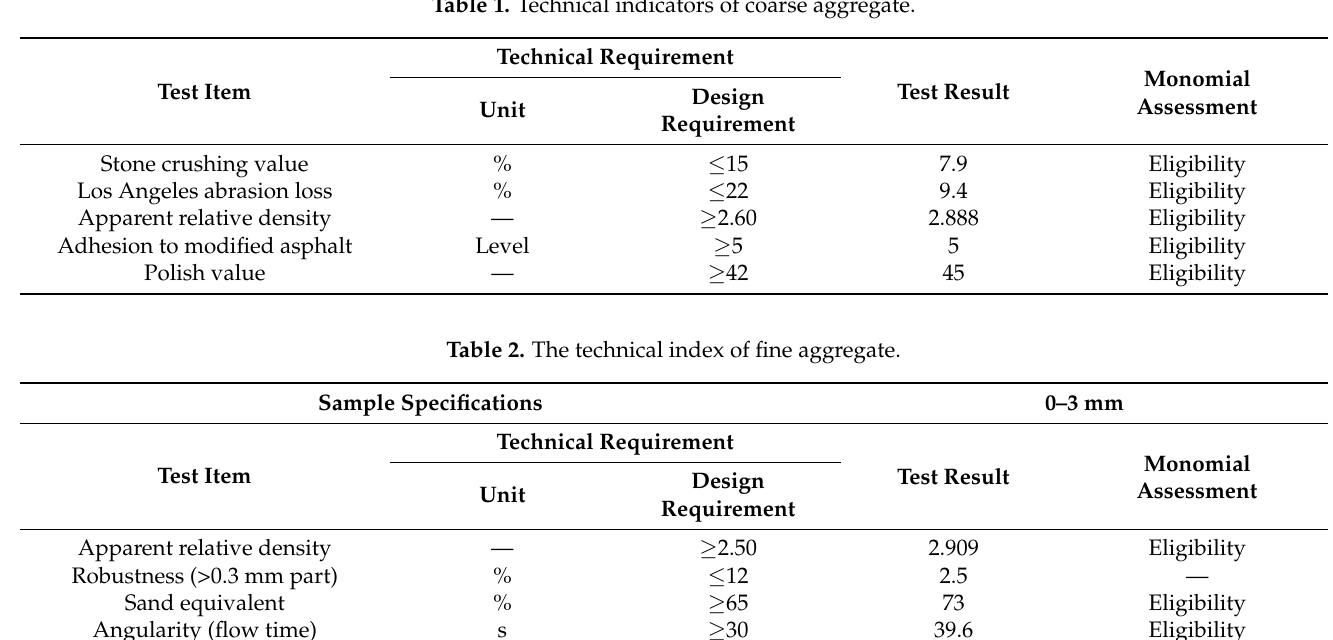
Table 1. Technical indicators of coarse aggregate.